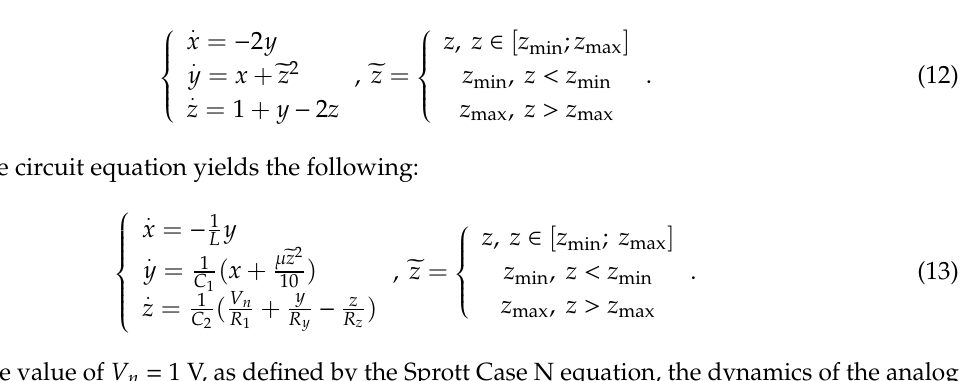
Figure 10. The analog circuit implementing the Sprott Case N chaotic oscillator with sensitive coil.